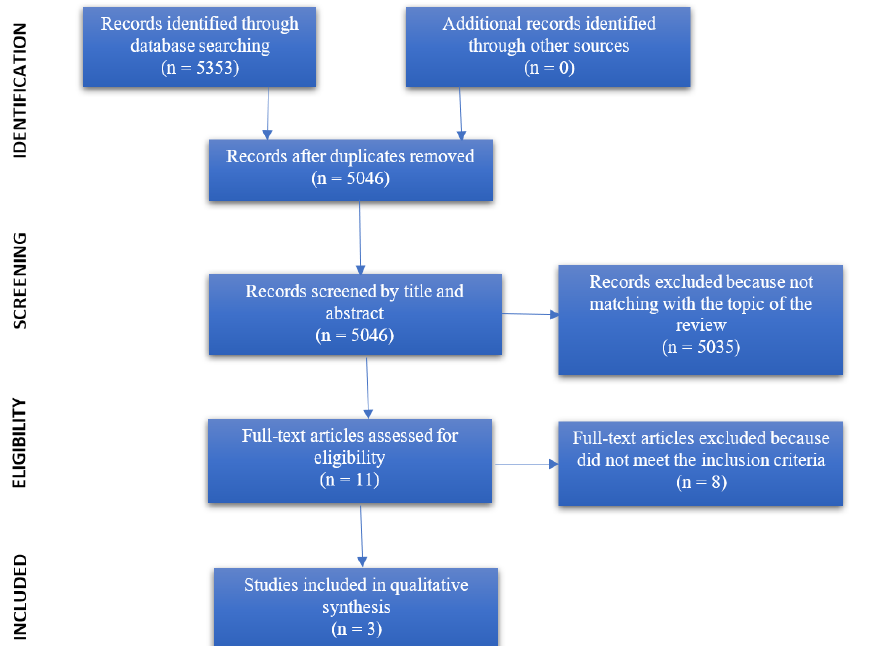
Figure 1. PRISMA 2009 flow diagram. Table 1. Articles included in the review. Legend: PANSS = The Positive and Negative Syndrome Scale; MADRS = Mont- gomery–Asberg Depression-Rating Scale; YMRS = Young Mania Rating Scale; SUMD = Scale to Assess Unawareness of Mental Disorder; EMA = Ecological Momentary Assessment; CPSS = Chinese Perceived Stress Scale; HAMD = Hamilton